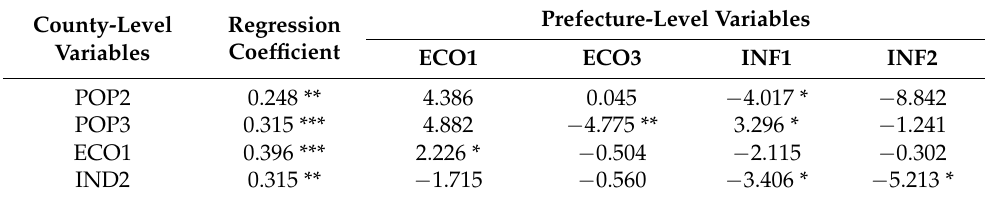
Table 4. The cross-level impact of prefecture-level cities on county-level towns. County-Level Variables